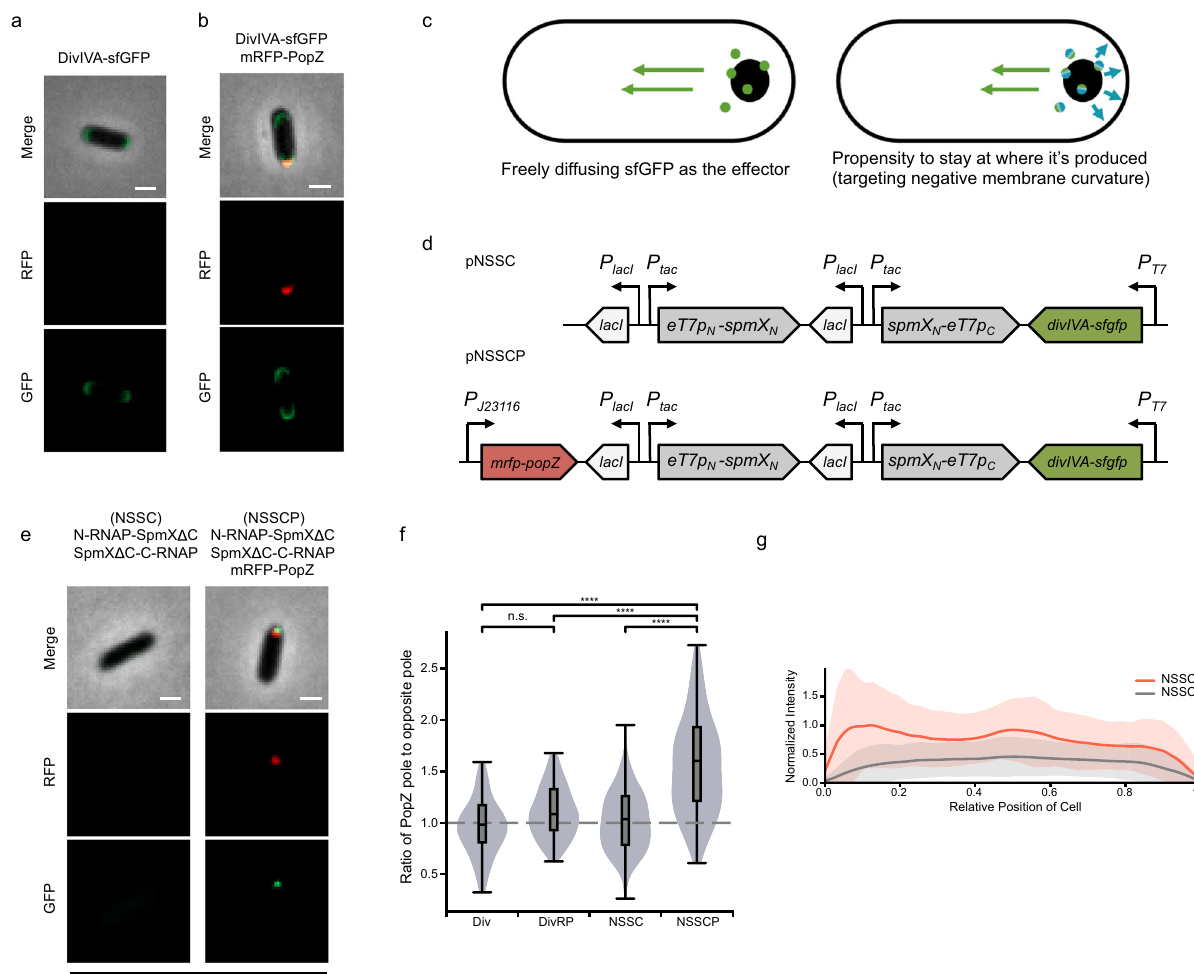
Fig. 4 Intracellular asymmetry arises when DivIVA is used as a reporter. a Localization of DivIVA-sfGFP when the expression was induced from the P tac promoter with 50 μ M IPTG for 1 h. Scale bars: 1 μ m. b Localization of DivIVA-sfGFP and mRFP-PopZ when the two were co-expressed. DivIVA-sfGFP expression was induced from the P tac promoter with 50 μ M IPTG for 1 h. mRFP-PopZ expression was induced from the P BAD promoter with 2% arabinose for 2 h. Scale bars: 1 μ m. c Graphic comparing freely diffusing GFP and limited diffusion via DivIVA. d Circuit diagram for asymmetric gene expression when DivIVA-sfGFP was used as the reporter. pNSSCP and pNSSC denote plasmids containing SpmX Δ C-fused RNAP halves expressed with or without mRFP- PopZ, respectively. eT7p N -spmX N denotes the SpmX Δ C-fused PACE-evolved RNAP-N; spmX N -eT7p C denotes the SpmX Δ C-fused PACE-evolved RNAP-C. Both SpmX Δ C-fused T7 RNAP halves were expressed from the IPTG-inducible promoter, P tac . divIVA-sfgfp is the reporter gene under the expression of T7 promoter. mrfp-popZ gene was expressed from the Anderson promoter J23116. e Asymmetric gene expression when DivIVA-sfGFP was used as a reporter. NSSCP and NSSC denote SpmX Δ C-fused RNAP halves expressed with or without mRFP-PopZ, respectively, with DivIVA-sfGFP as a reporter. SpmX Δ C- fused RNAP halves were induced from the P tac promoter with 50 μ M IPTG for 1 h. Scale bars: 1 μ m. f Quanti fi cation of DivIVA-sfGFP asymmetry in a , b , and e using the ratio between opposite poles ( “ Methods ” ). NSSCP and NSSC denote SpmX Δ C-fused RNAP halves expressed with or without mRFP-PopZ, respectively. Div denotes DivIVA-sfGFP expressed alone. DivRP denotes DivIVA-sfGFP co-expressed with mRFP-PopZ. The gray dashed line indicates one (i.e. no asymmetry); n = 89, 78, 99, and 91 cells for Div, DivRP, NSSC, and NSSCP, respectively. Center line, median; box limits, upper and lower quartiles; whiskers, 1.5× interquartile range. Statistical difference was determined by two-tailed Student ’ s t -test; **** denotes P < 0.0001. g Fluorescence intensity (sfGFP) pro fi les along the long axis of the cell when NSSC circuits were expressed alone (gray lines) or co-expressed with mRFP-PopZ (red lines); x = 0 marks the PopZ pole. Fluorescence intensity was normalized by the maximal mean intensity in NSSCP. Solid lines indicate averages; colored belts indicate standard deviations; n = 99 and 91 cells for NSSC and NSSCP, respectively. Source data are provided as a Source Data fi